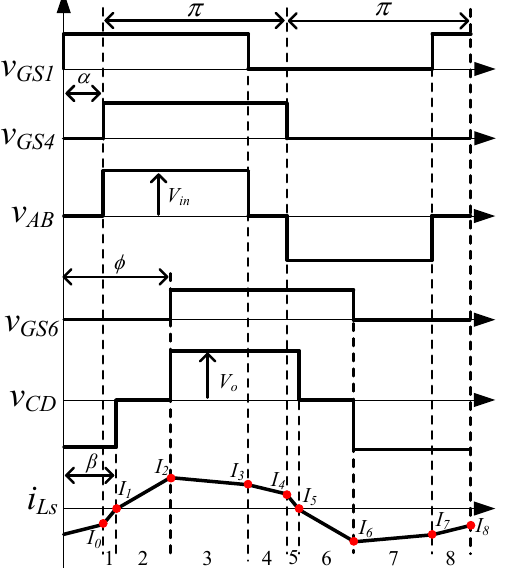
Figure 2. Steady-state waveforms in Mode